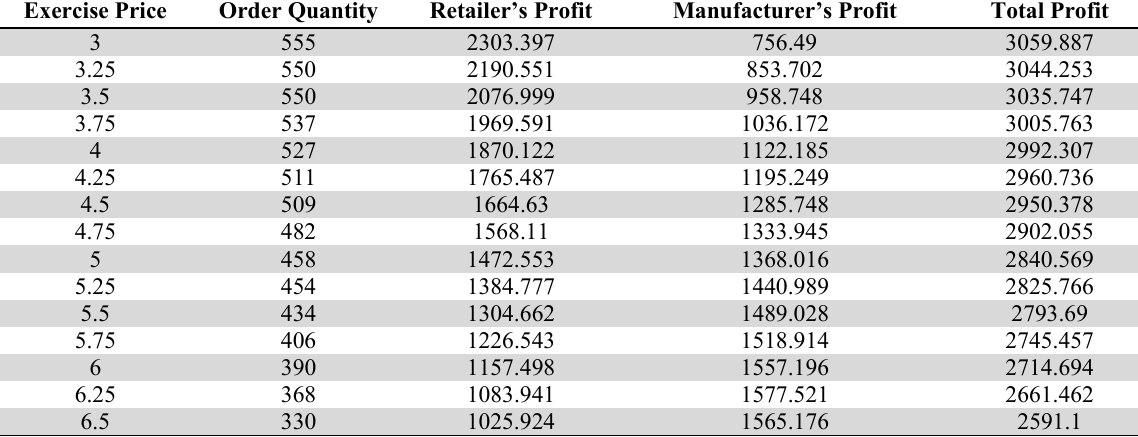
Effects of the exercise price on output of the model Exercise Price Order Quantity Retailer’s Profit Manufacturer’s Profit